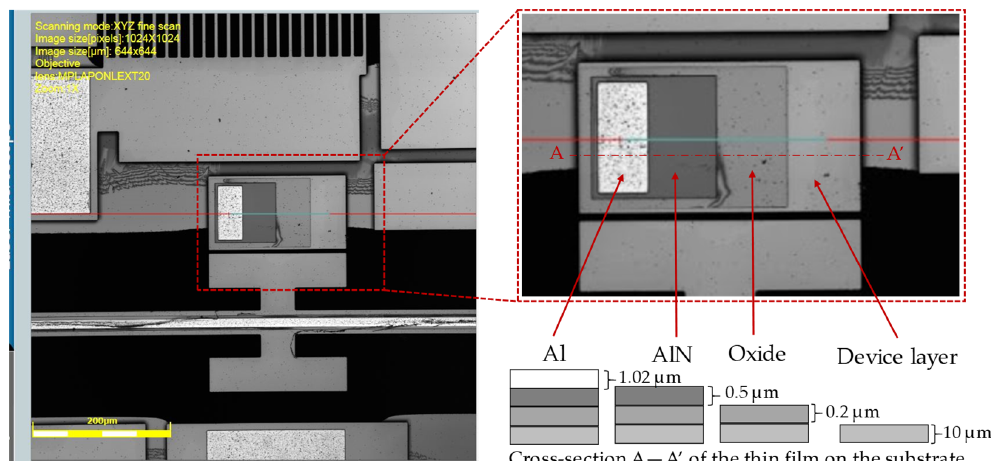
Figure 4. Multilayered test structure used for differential height measurements. Table 1. Measured height differences versus designed values.